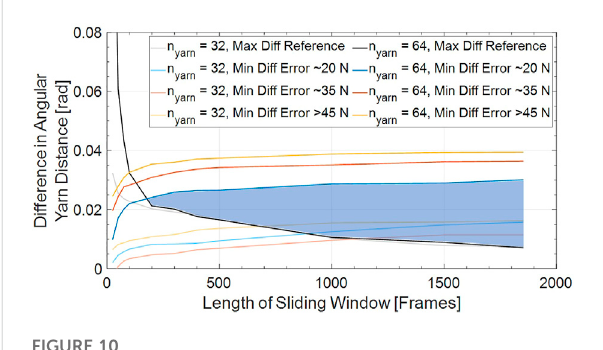
FIGURE 10 Comparison of maximum difference in angular yarn distance resulting from random process fl uctuations during fl awless reference measurements with minimum of defect-characteristic pattern during measurements with a replicated defect over different lengths of sliding averaging windows for the braiding experiments with 12 k yarns; blue-marked area indicates combinations of lengths of averaging windows and differences in angular yarn distances as possible detection thresholds for a defect detection without any false negative or false positive detections for n yarn (cid:1) 64 12 k